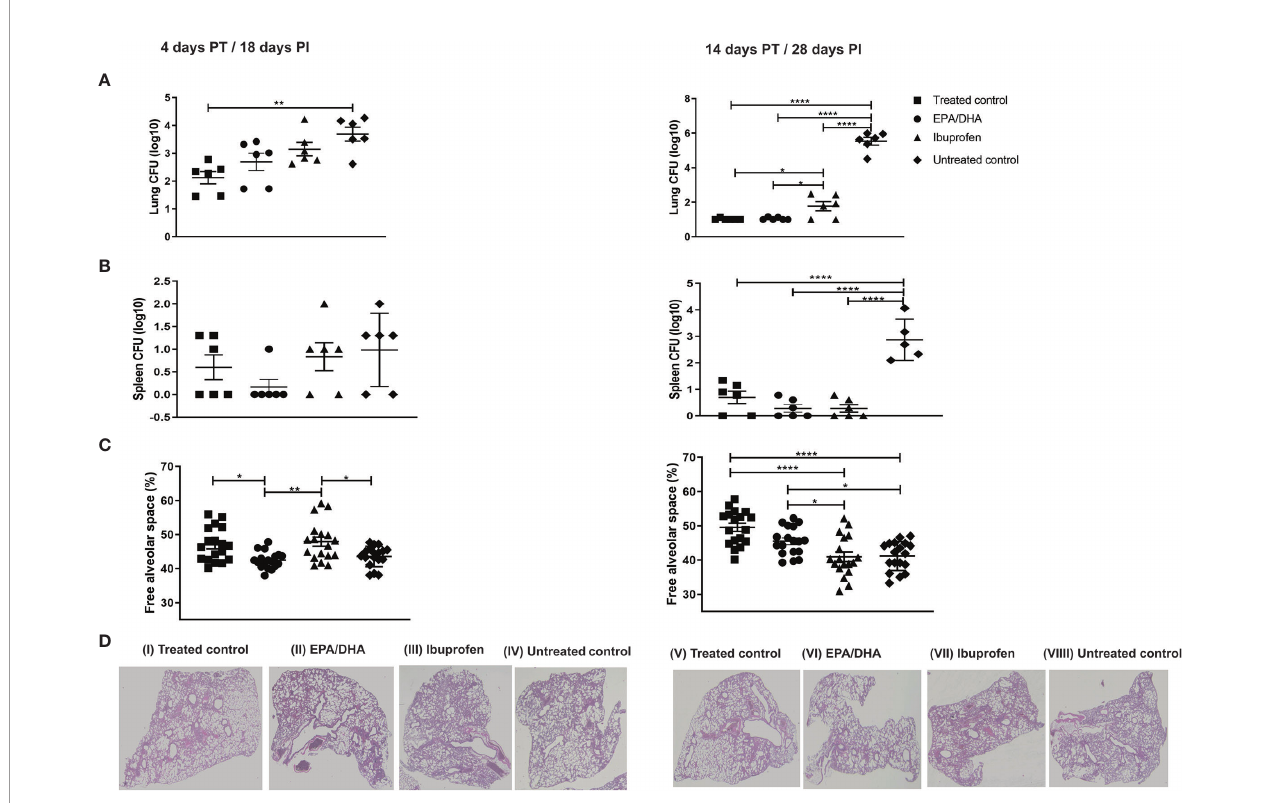
FIGURE 2 | Effect of adjunctive treatment on lung, spleen bacillary load and lung histopathology. (A) Lung bacillary load, (B) spleen bacillary load, (C) percentage of free alveolar space, and (D) haematoxylin-eosin stained sections of the lungs of selected representative group, after 18 [D(I-IV)] and 28[D(V-VIII)] days PI treatment period. All mice except untreated controls were on standard TB antibiotics Rifafour ® for 4 days of treatment, then rifampicin and isoniazid (RH) for 10 days. The data represented as mean ± SEM of n=6 mice/group and representative of two independent experiments. One-way ANOVA followed by the Tukey post-hoc test was used to compare means, signi fi cance at * P < 0.05, ** P < 0.01, ****P < 0.0001. CFU, colony-forming units; EPA, eicosapentaenoic acid; DHA, docosahexaenoic acid PT, post-treatment; PI,